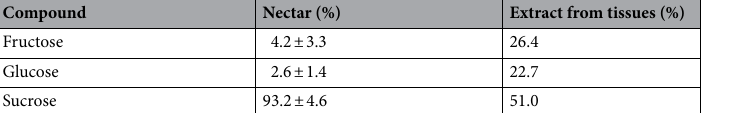
Compound Nectar